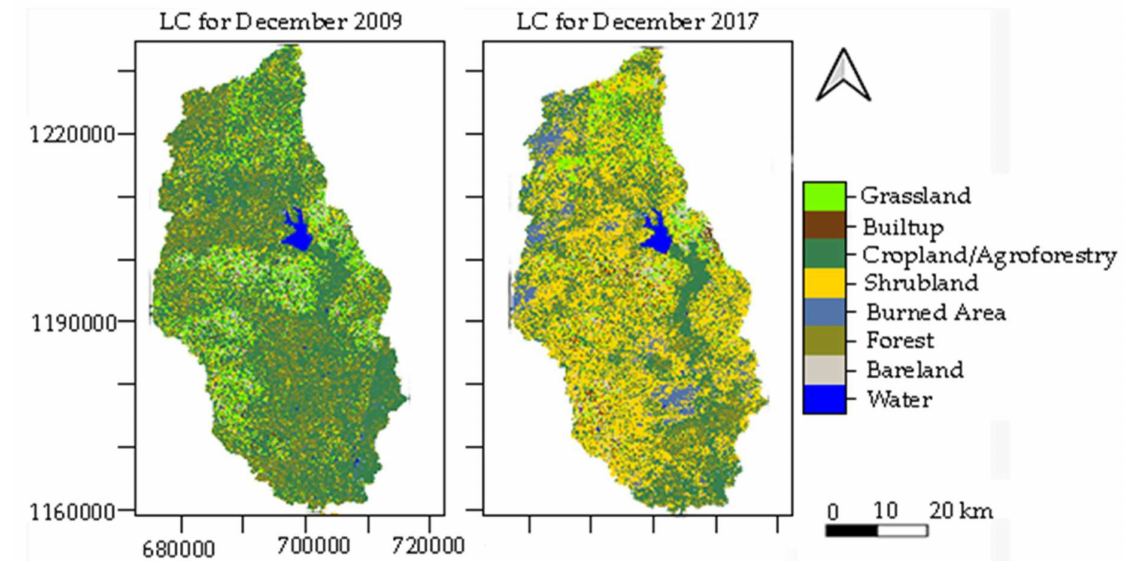
Figure 8. Land use map of Tono reservoir watershed based on multispectral satellite remote sensing data from ASTER L1T with 15 m spatial resolution.